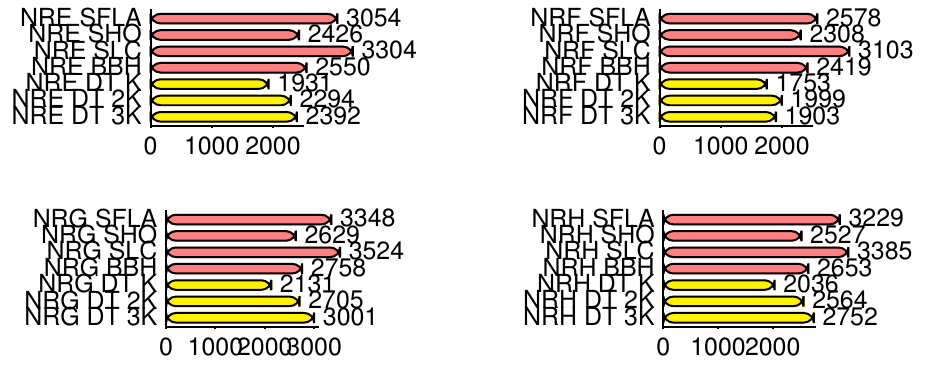
Figure 4. Average solving time comparison (mins). Table 5. 3K nodes RPD comparison for standalone and distributed